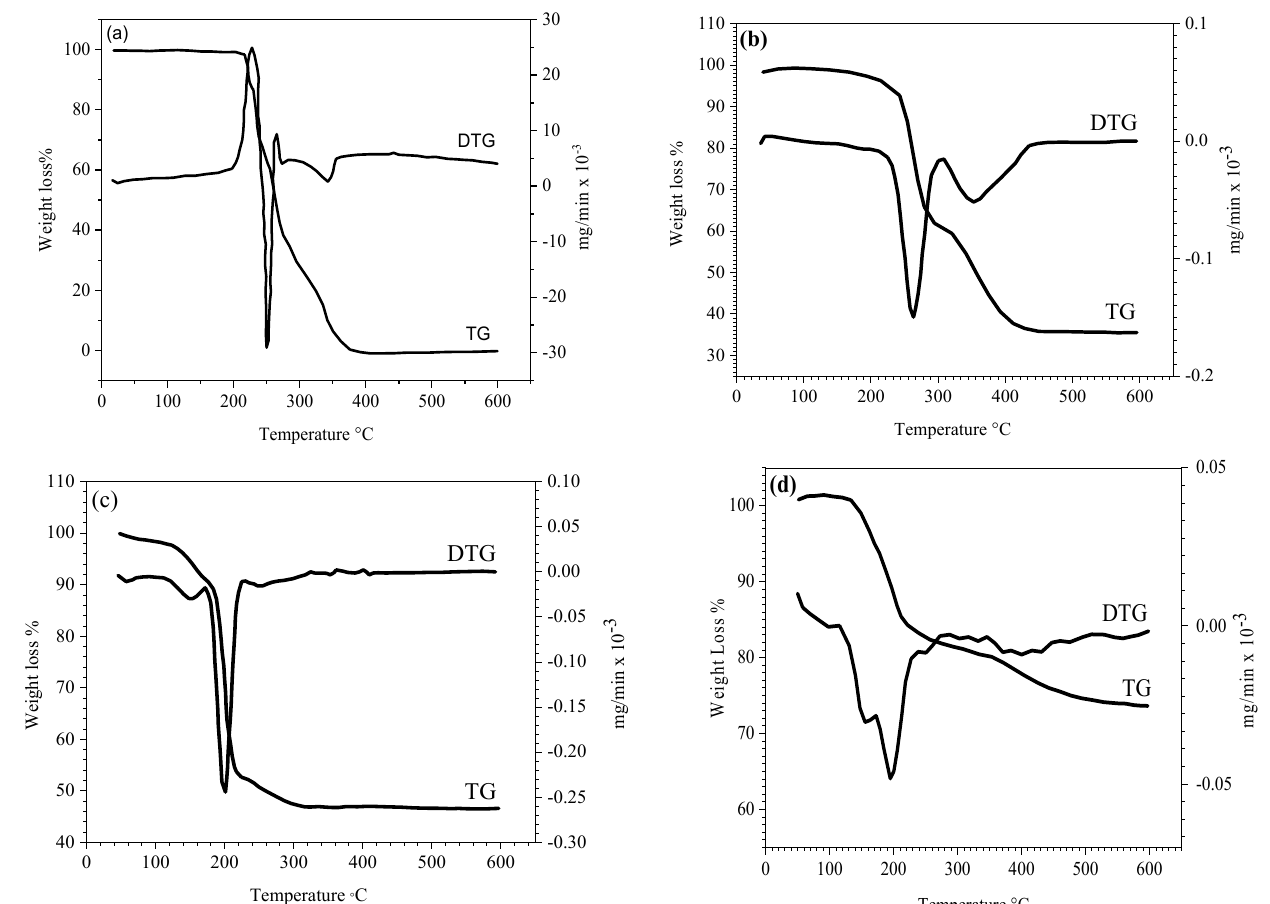
Figure 3. TG and DTG thermograms of ( a ) azodicarbonamide ( b ) Ni(II), ( c ) Cu(II), and ( d ) Zn(II) complexes. Table 3. The maximum temperature, T max (°C), and weight loss values of the decomposition stages for azodicarbonamide metal complexes.